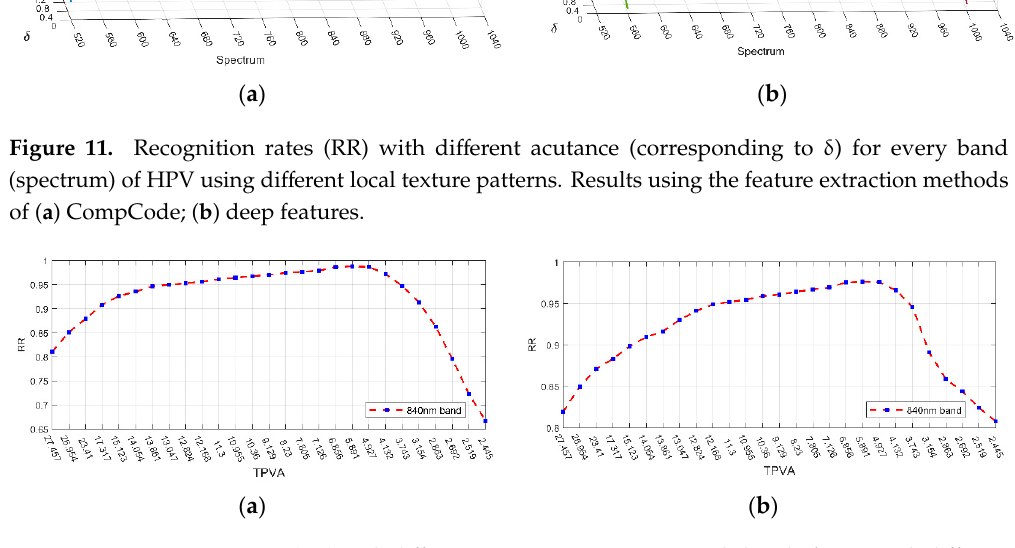
( b ) Figure 13. Recognition rates (RR) with different acutance (corresponding to δ ) for every band (spectrum) of HPV using different local texture patterns. Results using the feature extraction methods of ( a ) CompCode; ( b ) deep features ( a ) ( b ) Figure 14. Recognition rates (RR) with different acutance TPVA on the green band of HPV with different local texture patterns. Results using the feature extraction methods of ( a ) CompCode; ( b ) deep features. To draw conclusions more easily, the representative results of the best performing bands, in addition to the average results for all bands in each hyperspectral database are depicted in the Table. 1. From this table it can be seen that for every case, after adjusting image acutance (from the optimal range) the RR increases when compared to the original ROI image, no matter which local feature extractor was used.